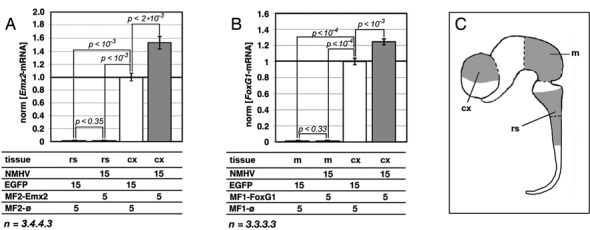
Lack of responsivity to Emx2- and FoxG1-specific ribo-transactivators by neural precursors of non-cortico-cerebral origin. (A) Unchanged Emx2-mRNA levels in E10.5 rhombo-spinal precursors, infected by NMHV- and MF2-Emx2-encoding lentiviruses or EGFP- and MF2-øcontrols. (B) Unchanged FoxG1-mRNA levels in E10.5 mesencephalic precursors, infected by NMHV- and MF1-FoxG1-encoding lentiviruses or EGFP and MF1-øcontrols. In both (A) and (B), transactivation of the two genes in E12.5 cortico-cerebral precursors is shown, as a positive control. Moreover, in both cases, results were normalized against Gapdh and further normalized against E12.5 cortico-cerebral precursors treated by EGFP/MF2-øand EGFP/MF1-øcombinations, respectively. Time frame of the experiments as well as representation of moi's and statistical parameters is as in Figure 3. (C) Idealized representation of the murine E10.5 neural tube. cx, cerebral cortex; m, mesencephalon; rs, rhombo-spinal tract.